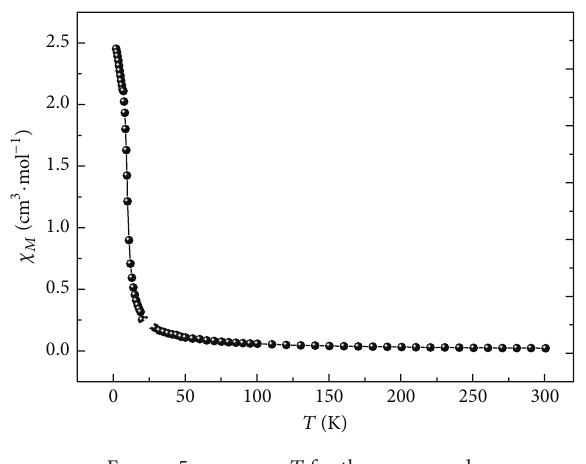
Figure 5: 𝜒 𝑚 versus 𝑇 for the compound.